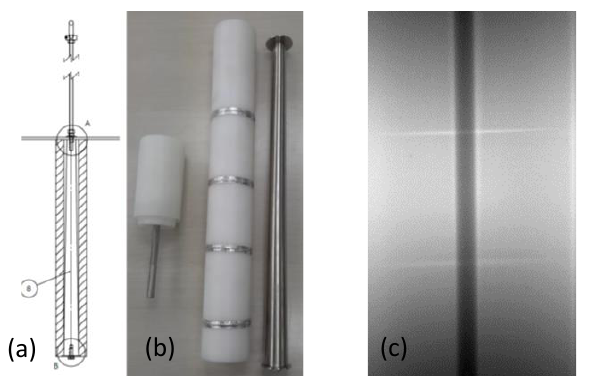
Fig. 9. (a) A schematic, and (b) the components of a phantom used to determine the detection limit for vapor films, with (c) the corresponding X-ray image acquired at the MELT